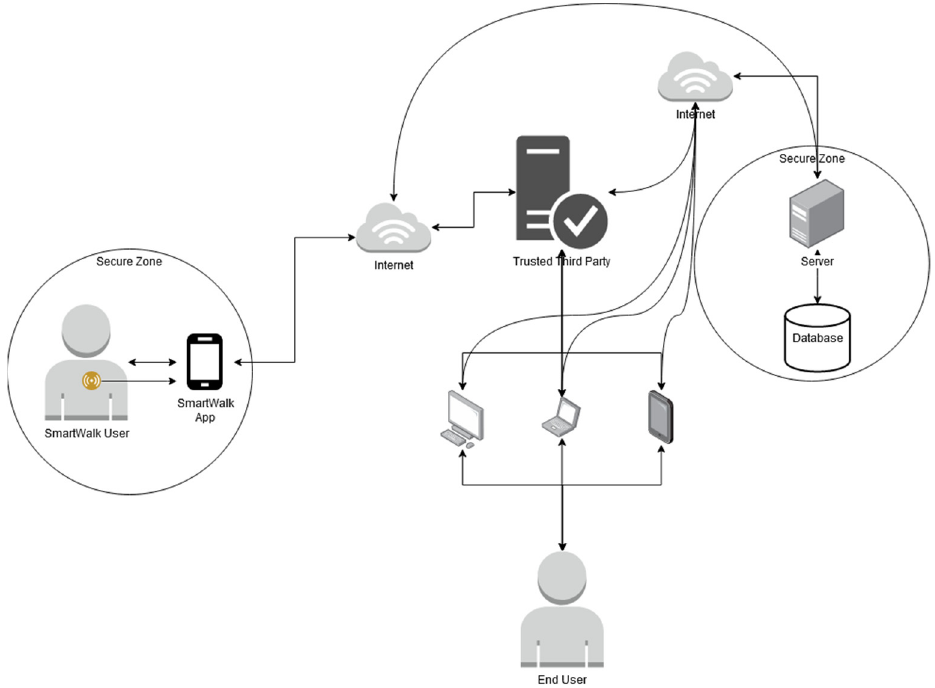
Figure 2. Security mechanisms architecture.